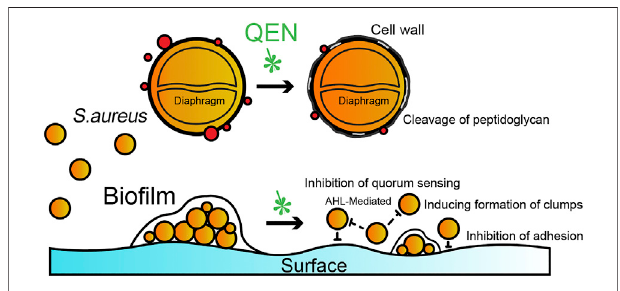
FIGURE 8 | Potential schematic illustration of QEN inhibition on S. aureus and bio fi lms.Theinhibition mechanism ofQENisbacterial colonization and adhesion by modulating quorum